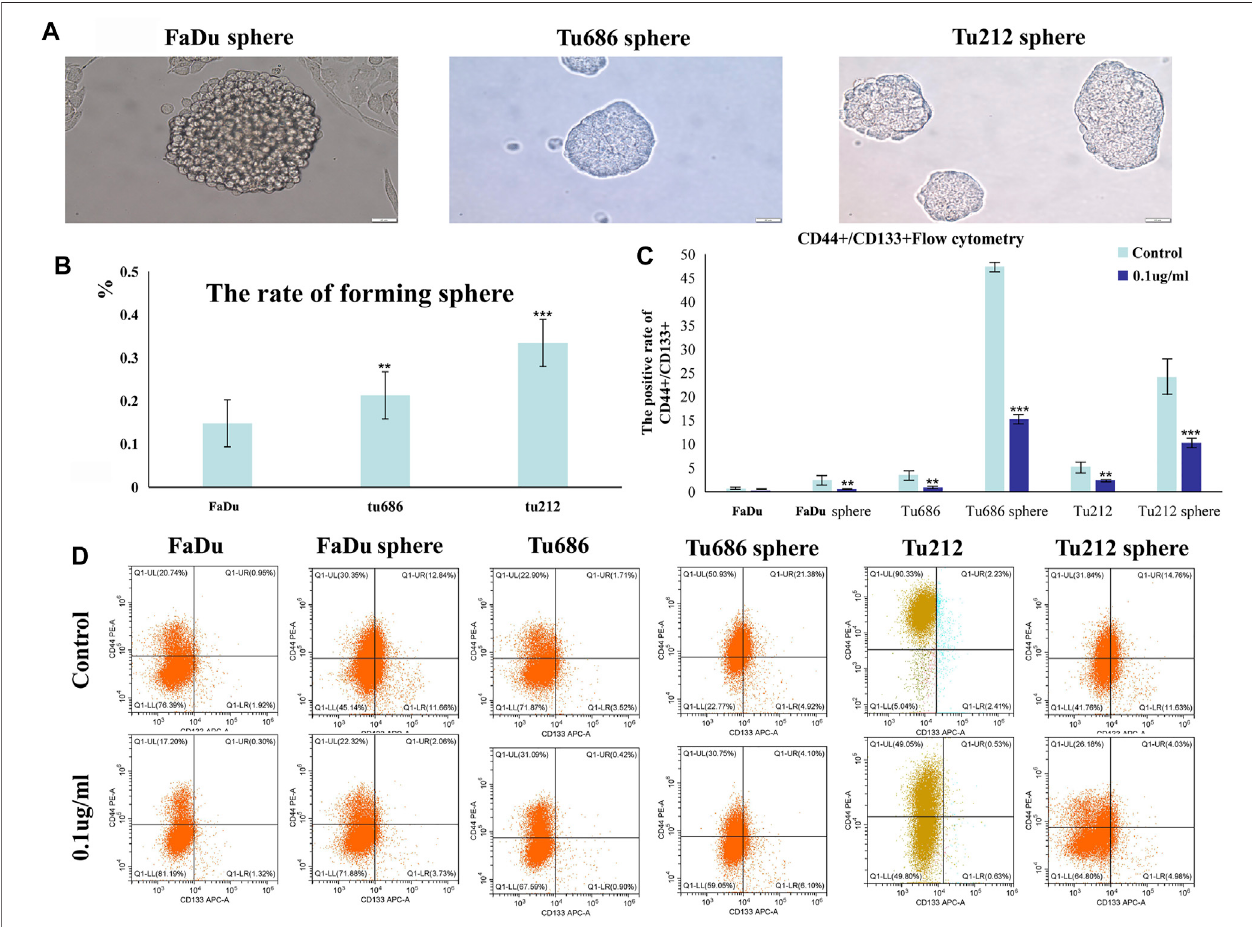
FIGURE 5 | Growth of human squamous cell carcinoma microsphere cells cultured in the serum-free medium. (A) Human squamous cell carcinoma spheres generatedinSFM. (B) Thestatistical fi gureofformingsphererate. (C) ThepositiverateofCD44+/CD133+by fl owcytometry. (D) Representative fl owcytometrypictures ofthe cellstem areshown. Bars, 50 µm.All the experiments were carried out threetimes. Thebar graphsand the table show quanti fi cation oftheresults, and each data represent the mean ± SD of three independent experiments (* p < 0.05; ** p < 0.01; *** p < 0.001 vs the control group).